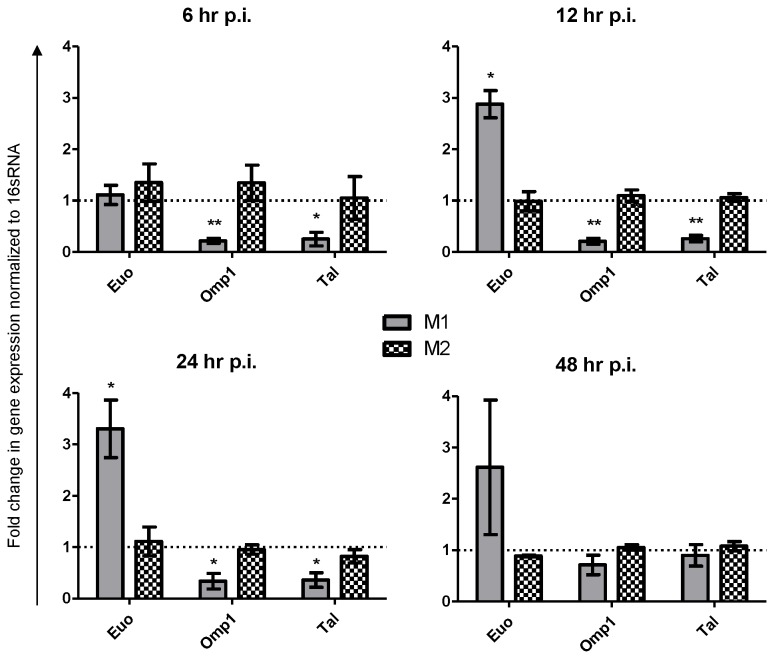
Control of
Chlamydia
 by M1 macrophages involves the induction of persistence as demonstrated by RT-PCR.Polarized macrophages were infected for the indicated timepoints.
Chlamydia
 gene expression is not altered by growth in M2 macrophages versus growth in M0 macrophages. In M1 macrophages, a gene expression profile characteristic of persistence was seen from 6 hr p.i. infection to 24 hr p.i. whereby Euo was up-regulated and Omp1 and Tal were down-regulated. Data is mean ±SEM of three independent experiments and was analyzed using one-sample t-test against hypothetical mean of 1.0.